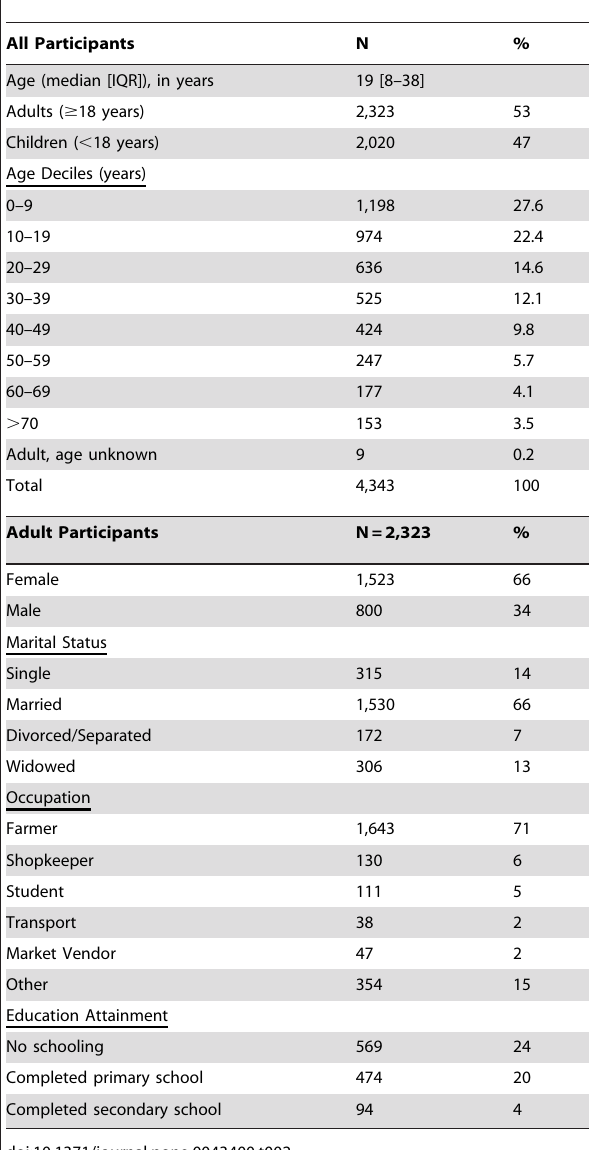
Table 2. Demographic Characteristics of Kakyerere Parish Community Health Campaign